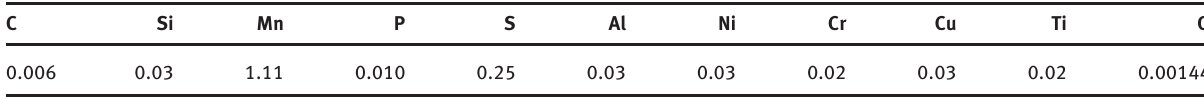
Table 1: The composition of the steel (Mass Percent/mass